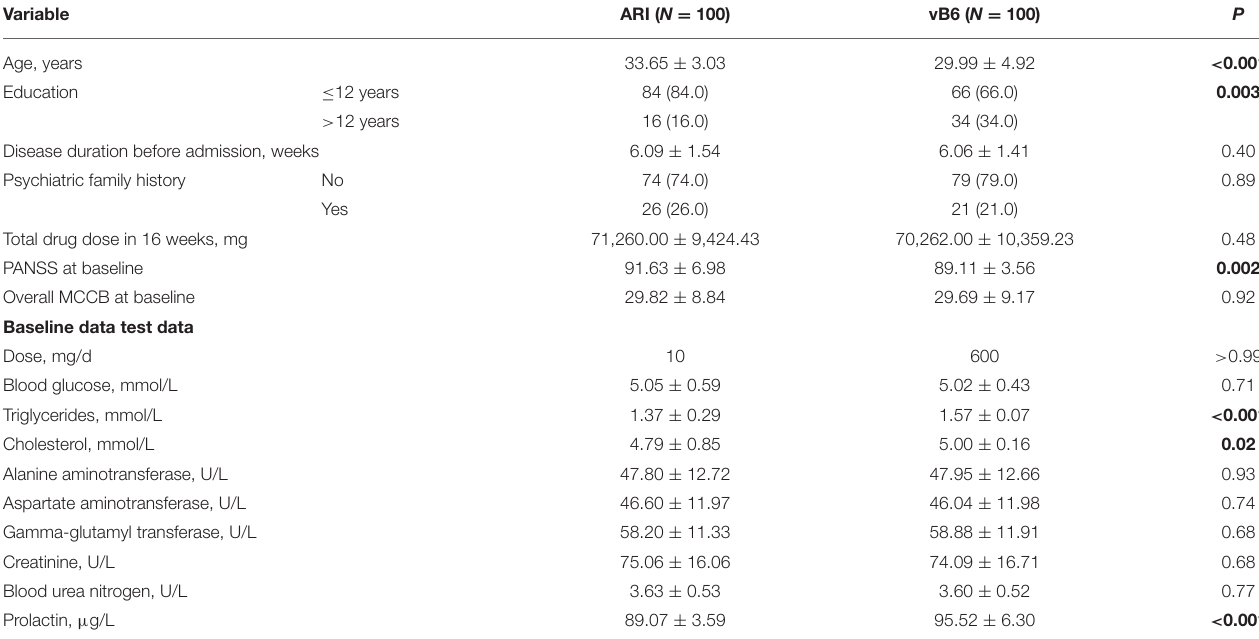
TABLE 1 | Demographic and clinical characteristics at baseline, medication use, and biochemical assessment during treatment in patients with TRS by treatment group. Variable